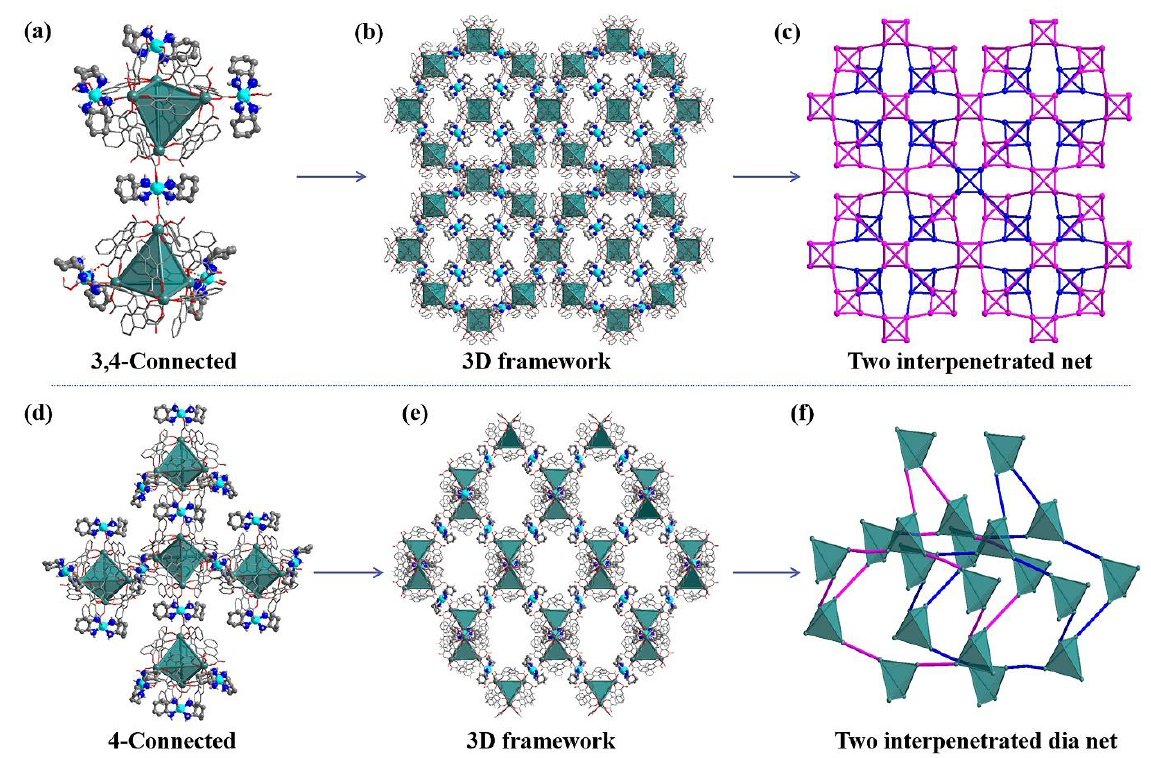
Figure 2. ( a , b , d , e ) The connectivity between Zr 4 L 6 cages and [Zn(cis-DCH)2] 2+ cation creates a 3D framework PTC-358 and PTC-359 , respectively, and their interpenetrated networks ( c , f ). Atom color code: green, Cu; powder blue, Zn; olive, Zr; red, O; blue, N; gray, C; off white, H. Some H atoms have been removed for clarity.